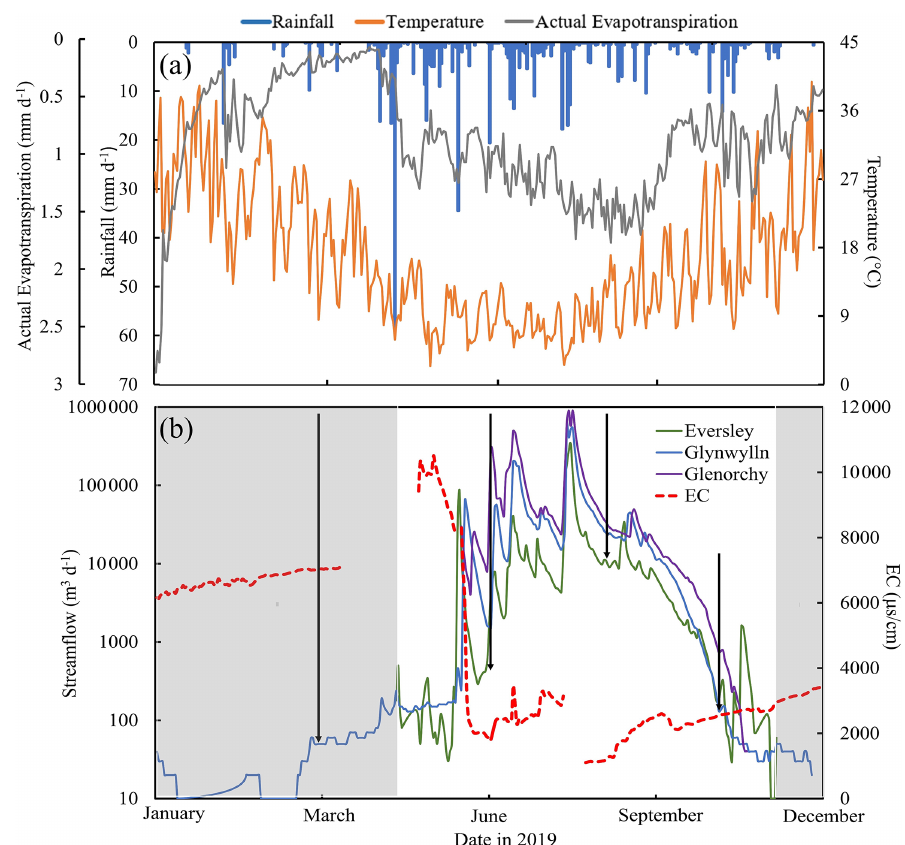
Figure 2. (a) Variations in daily rainfall, daily actual evapotranspiration, and temperature and (b) electrical conductivity (EC) at Glynwylln (missing data are caused by measurement errors of equipment) and streamflow at Eversley, Glynwylln, and Glenorchy (Fig. 1) in the upper Wimmera River in 2019. Sampling times are indicated by arrowed lines. Shaded areas represent the zero-flow periods. Data from Department of Environment, Land, Water and Planning (2021) and Bureau of Meteorology